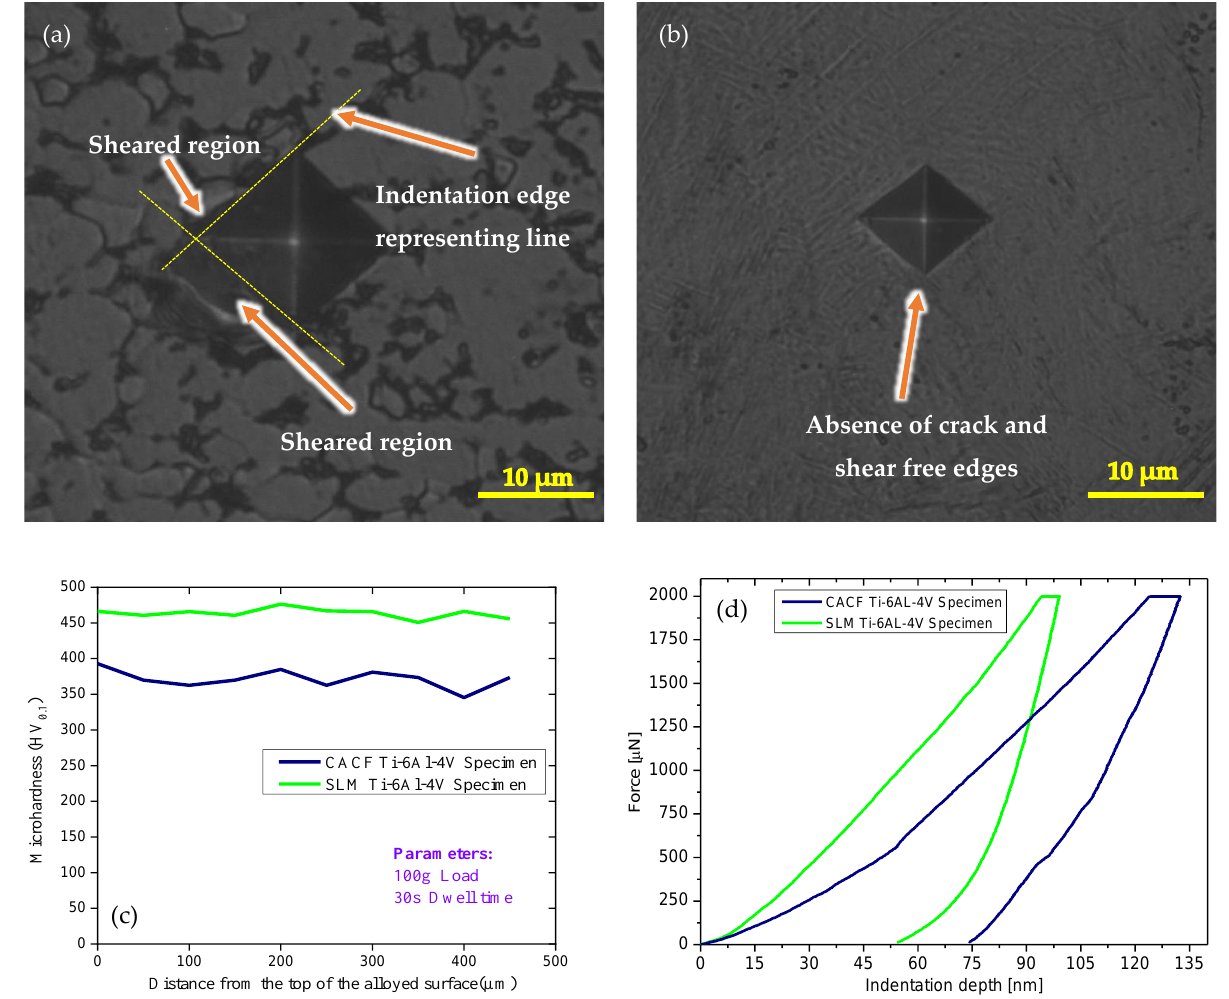
Figure 5. ( a , b ) Microhardness indentation marks on CACF and SLM specimens, respectively. ( c ) Microhardness graph of CACF and SLM specimens. ( d ) Nanohardness profiles with their corresponding indent marks for CACF and SLM specimens.